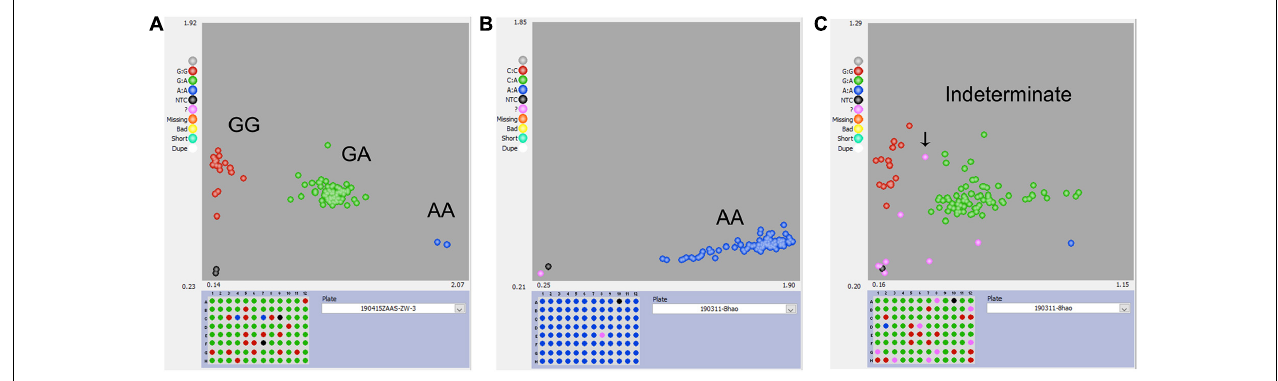
FIGURE 3 | Representative results of KASP genotyping assay. (A) KASP marker with good polymorphism that was successfully developed. (B) KASP marker with no polymorphism that should be discarded. (C) KASP marker with more than 10% missing values or had ambiguous SNP-calling that should be